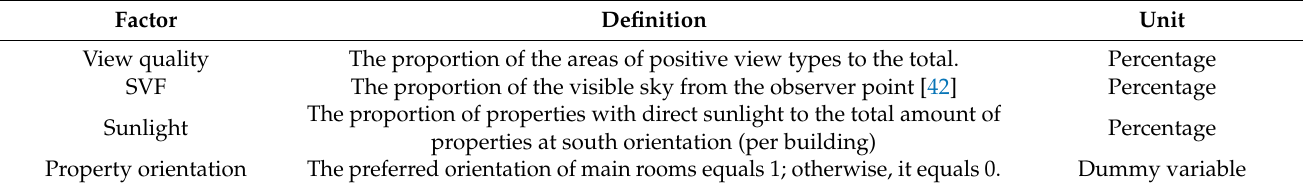
Table 3. Overview of 3D